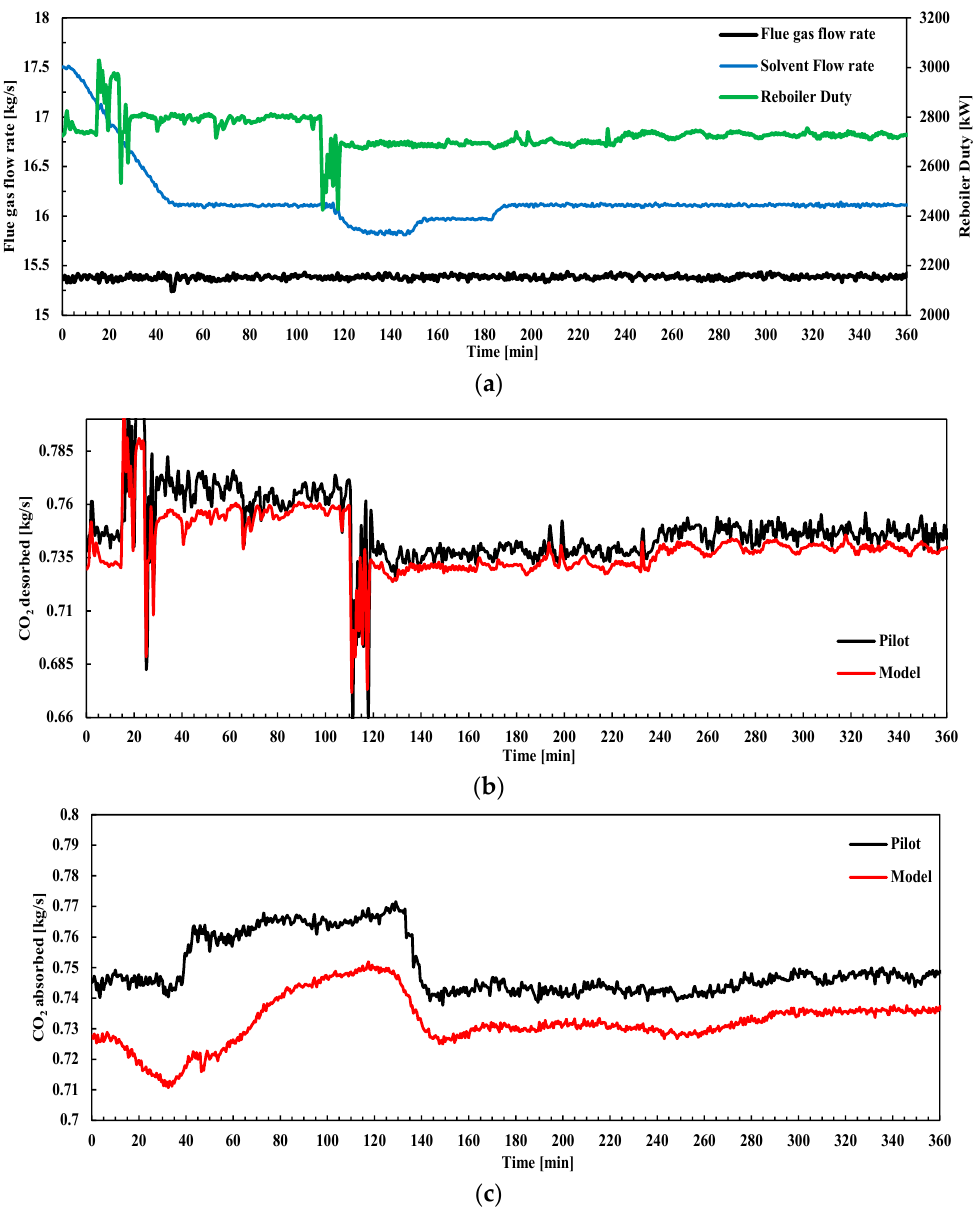
Figure 7. ( a ) Main inputs to the plant. Flue gas volumetric flow rate set-point change increase (kg/s). Rich solvent flow rate from absorber (kg/s) and steam flow to reboiler (kg/s); ( b ) Pilot plant transient response and model output trajectory for CO 2 product flow rate F prod or CO 2 desorbed (refer to FT3 in Figure 1); ( c ) Pilot plant response in CO 2 absorbed mass flow rate (kg/s). The time t = 0 corresponds to the point from which the set point of rich solvent flow rate was changed.